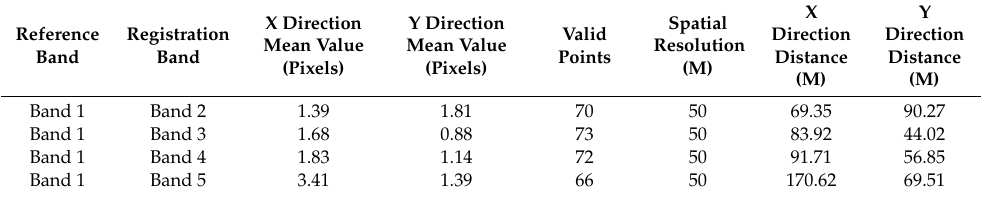
Table 1. Results of the band registration accuracy evaluation of a single frame of a Gaofen-4 (GF-4) satellite